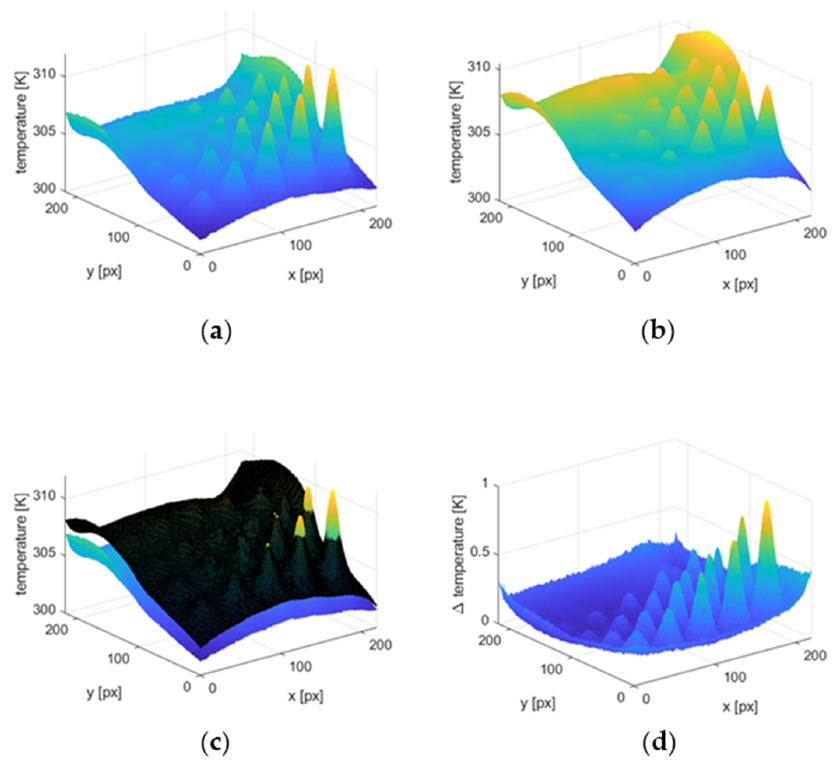
Figure 11. Procedure of the trend removal. ( a ) The original thermogram, ( b ) approximated thermo- gram, ( c ) overlay of the original image and its approximation, ( d ) the result of the subtraction of the approximation from the original.